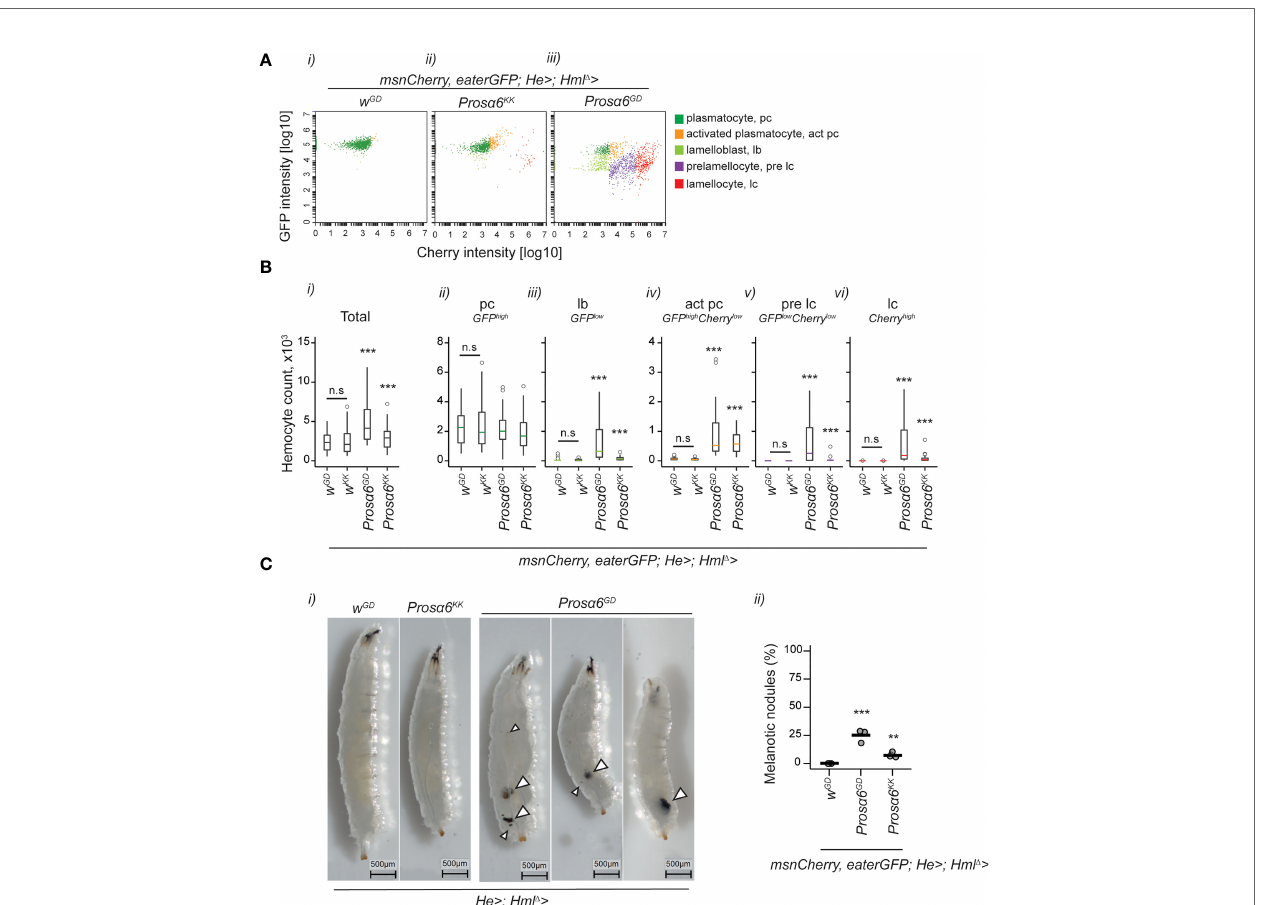
FIGURE 4 | Pros a 6 silencing in hemocytes leads to an increase in total hemocyte numbers and to the formation of activated hemocytes. (A) Examples of fl ow cytometry plots showing hemocytes expressing eaterGFP (a plasmatocyte marker) and msnCherry (a lamellocyte marker). A wild-type larva had mainly eaterGFP - positive plasmatocytes (i) , whereas Pros a 6 silencing in hemocytes ( msnCherry,eaterGFP;Hml D -GAL4;He - GAL4/UAS-Pros a 6 ) resulted in the formation of lamellocytes ( ii ) or a full-blown activation of hemocytes ( iii ). (B) Quanti fi cation of total hemocytes (i) and each hemocyte class ( ii-vi ) from control ( msnCherry,eaterGFP;Hml D -GAL4; He - GAL4/w GD and msnCherry,eaterGFP;Hml D -GAL4; He - GAL4/w KK ) larvae and from larvae with Pros a 6 silencing in hemocytes ( msnCherry,eaterGFP;Hml D -GAL4; He - GAL4/UAS-Pros a 6 GD and msnCherry,eaterGFP;Hml D -GAL4; He - GAL4/UAS-Pros a 6 KK ). Each genotype was replicated three times, 10 animals in each replicate. Error bars show mean and lower and upper 95% con fi dence limits (cl). Grey dots represent individual animals. Data on hemocytes were analyzed using a negative binomial GLM. Stars indicate a signi fi cant difference when compared to the control sample. The two control backgrounds were also compared to each other. n.s., not signi fi cant; ***p < 0.001; pc, plasmatocyte; act pc, activated plasmatocyte; lb, lamelloblast; pre lc, prelamellocyte; lc, lamellocyte. (C) , i ) Examples of larvae without and with melanotic hemocyte aggregates of varying sizes, some of which are marked with arrowheads. For nodule quanti fi cation, each genotype was replicated three times, with 100 animals in each replicate (ii). Data were analyzed as a proportion of animals bearing nodules, using a GLM with binomial distribution combined with Tukey ’ s post-hoc test. ***p < 0.001; **p <